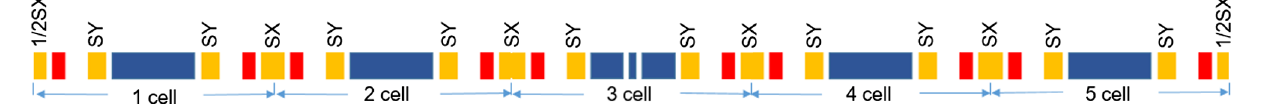
FIG. 15. Positioning of chromatic sextupoles.